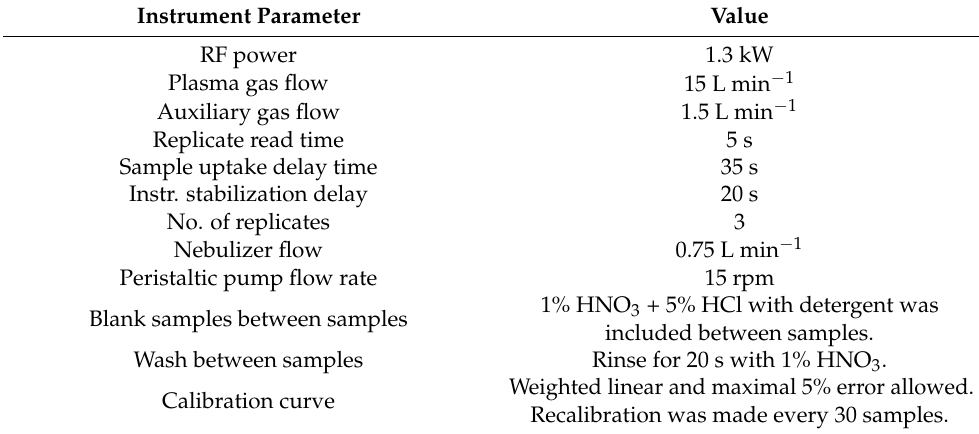
Table 1. Optimized instrument